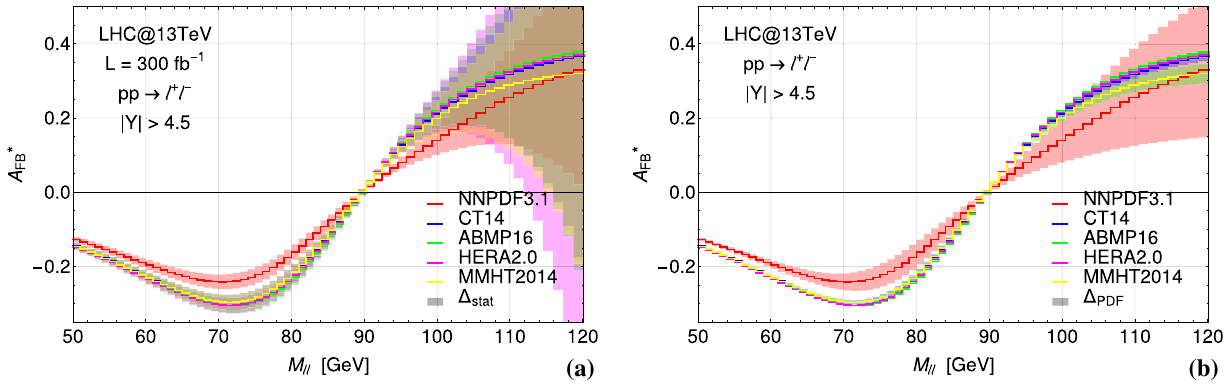
Fig. 5 Number of events as a function of the di-lepton invariant mass including the a statistical and b PDF errors for a rapidity cut | Y ll | > 4 . 5. A luminosity L = 300 fb − 1 is assumed and acceptance cuts | η | < 5 and p T > 20 GeV are imposed on both leptons